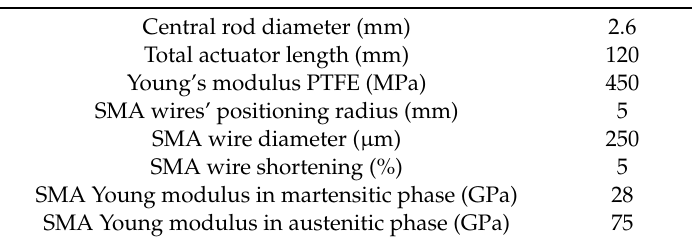
Table 1. Actuator main data.